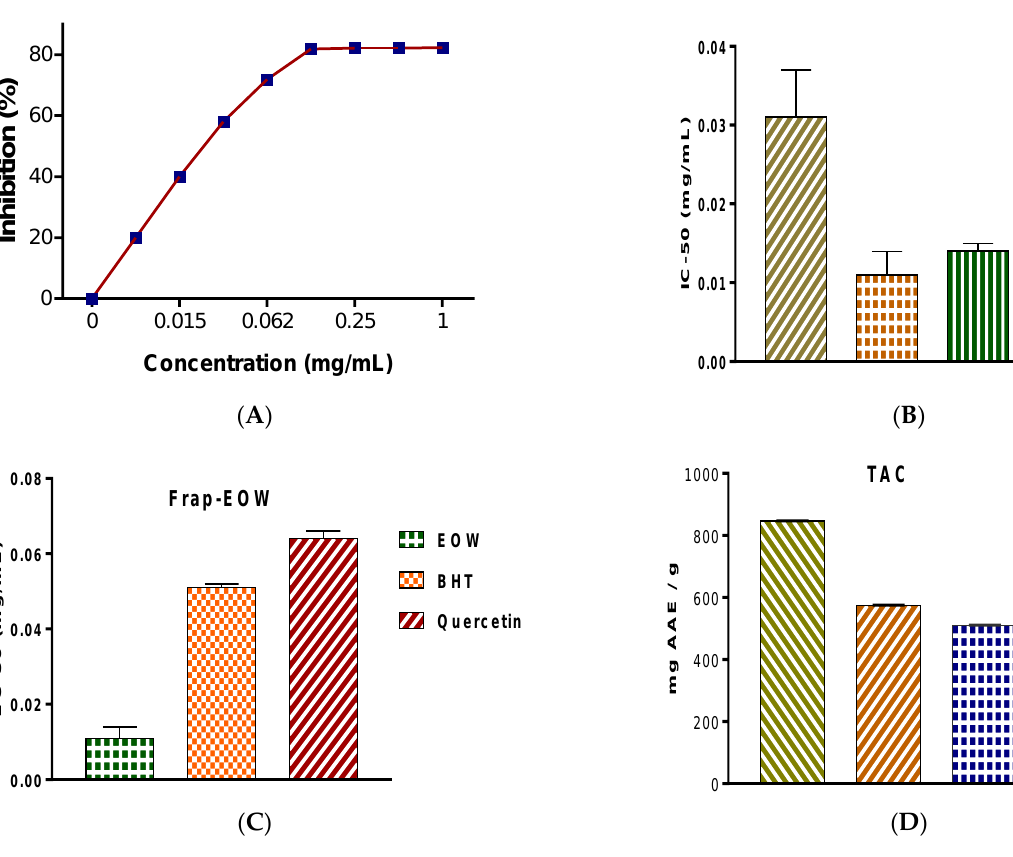
Figure 2. Antioxidant activity of EOW with positive controls: ( A ) Inhibition percentage of DPPH free radicals using various concentrations of EOW; ( B ) IC50 values of antioxidant activity of EOW using DPPH assay; ( C ) EC 50 values of EOW obtained using FRAP assay; ( D ) Total antioxidant capacity of EOW given in mg of ascorbic acid equivalent per gram of EOW.